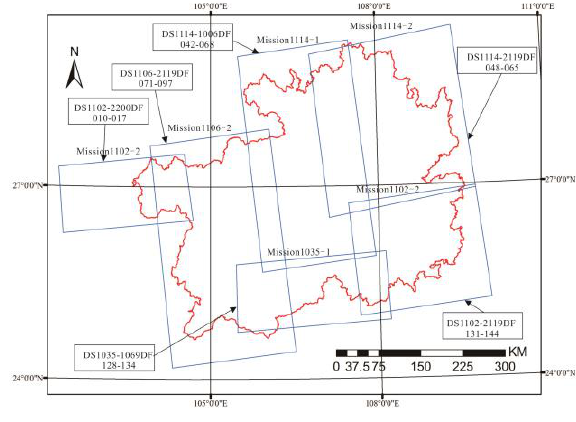
Figure 2. The coverage area of DISP imagery in Guizhou